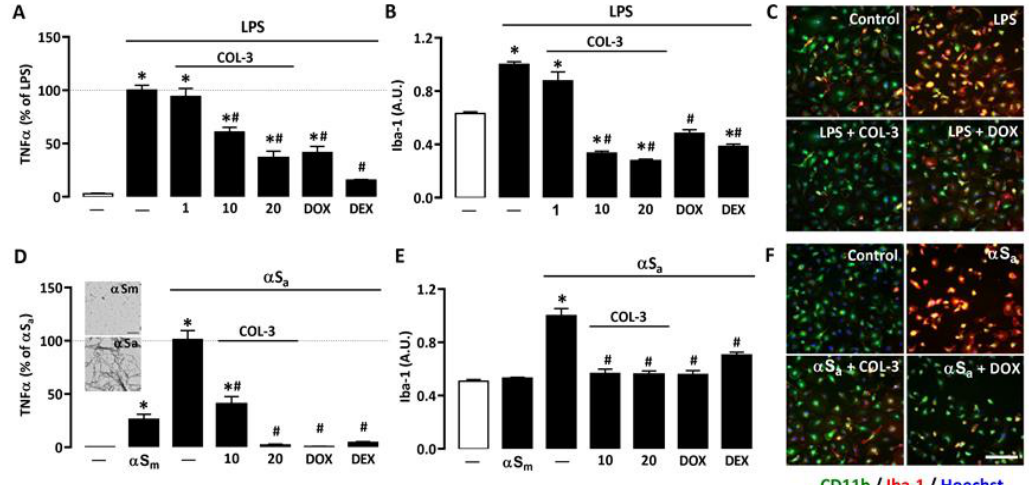
Figure 2. COL-3 reduces inflammatory responses in microglial cells exposed to either LPS or α Sa. ( A ) TNF- α levels in microglial cell cultures exposed to LPS (10 ng/mL, 24 h) in the presence or absence of COL-3 (1, 10, or 20 µ M), DOX (50 µ M), or the reference anti-inflammatory drug DEX (2.5 µ M). Data are the mean ± SEM ( n = 4). * p < 0.05 vs. control; # p < 0.05 vs. LPS. One-way ANOVA followed by Bonferroni post-hoc test. ( B ) Quantification of Iba-1 immunofluorescence signals in microglial cell cultures treated as in ( A ). ( C ) Merged images of CD11b (green) and Iba-1 (red) immunofluorescence signals in LPS (10 ng/mL)-treated microglial cell cultures receiving COL-3 (20 µ M) or DOX (50 µ M). The reddish/yellow fluorescence denotes overexpression of Iba-1. Cell nuclei are counterstained with Hoechst-33342 (blue). ( D ) TNF- α levels in microglial cell cultures treated with α Sa (70 µ g/mL, 24 h) in the presence or absence of COL-3 (10 and 20 µ M), DOX (50 µ M), or DEX (2.5 µ M). Some cultures were also exposed to α Sm (70 µ g/mL). Data are the mean ± SEM ( n = 4). * p < 0.05 vs. control; # p < 0.05 vs. α Sa. One-way ANOVA followed by Bonferroni post-hoc test. TEM images from the insert show the presence of α S amyloid fibrils in α S samples shaken for 96 h (lower image) and the absence of aggregated species in non-shaken samples (upper image). Scale bar = 1 µ m. ( E ) Quantification of Iba-1 immunofluorescence signals in microglial cultures exposed to the same treatments as in ( D ). Data are the mean ± SEM ( n = 4). * p < 0.05 vs. control; # p < 0.05 vs. α Sa. One-way ANOVA followed by Bonferroni post-hoc test. ( F ) Merged images of CD11b (green) and Iba-1 (red) immunofluorescent signals in α Sa (70 µ g/mL)-treated microglial cell cultures receiving COL-3 (20 µ M) or DOX (50 µ M). The reddish/yellow fluorescence denotes overexpression of Iba-1. Cell nuclei are counterstained with Hoechst-33342 (blue). Scale bar = 120 µ m. Data are the mean ± SEM ( n = 4). * p < 0.05 vs. control; # p < 0.05 vs. LPS or α Sa. One-way ANOVA followed by Bonferroni post-hoc test.